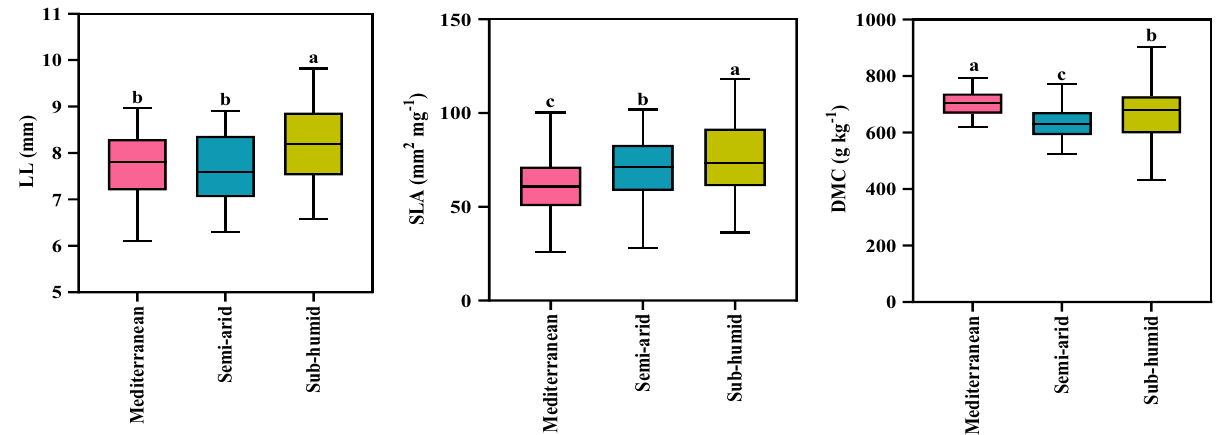
Figure 1. Leaf morphological traits of Quercus brantii in three different climates. Leaf length (LL), specific leaf area (SLA), dry matter content (DMC). Vertical bars in each column represent Standard Deviation. Lowercase letters indicate significant differences between three climates (Duncan’s multiple range test). The same letters do not significantly differ ( P <